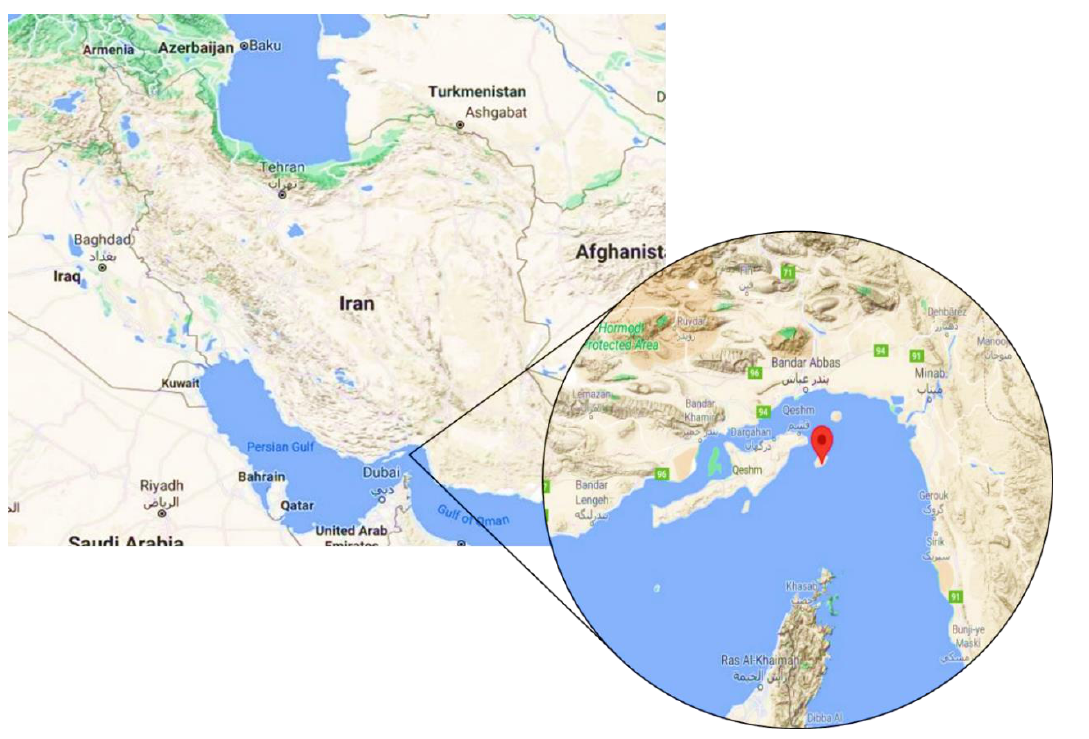
Figure 4. Location of Larak Island in the south of Iran [google maps].